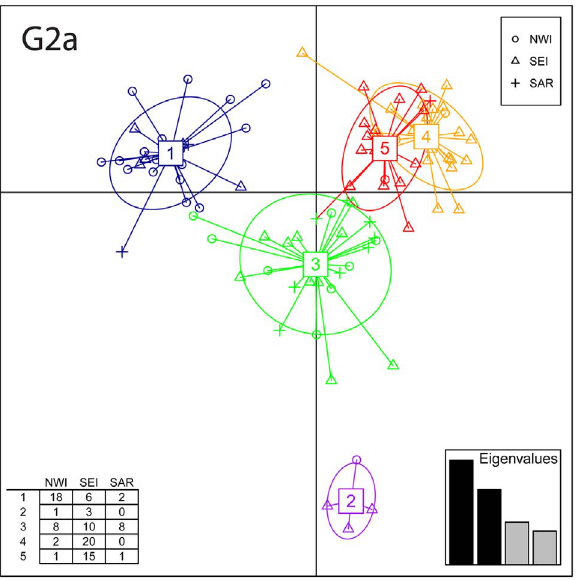
Figure 2. Discriminant Analysis of Principal Components (DAPC) for G2a-P15 haplotypes. Samples are grouped according to their affiliation at the sPCA-identified groups (NWI; SEI; SAR; symbols in the top right table). The table in the bottom left shows the number of haplotypes in each of the five G2a clusters and their geographical distribution in the three Italian areas. DAPC eigenvalues are depicted in the enclosed barplot.